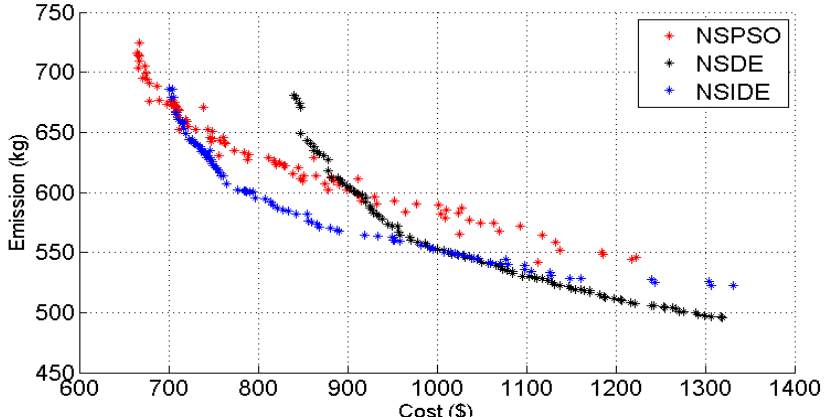
Figure 11. Results of implementing different methods considering the limitations of upstream grid power exchange (cost and emission based).